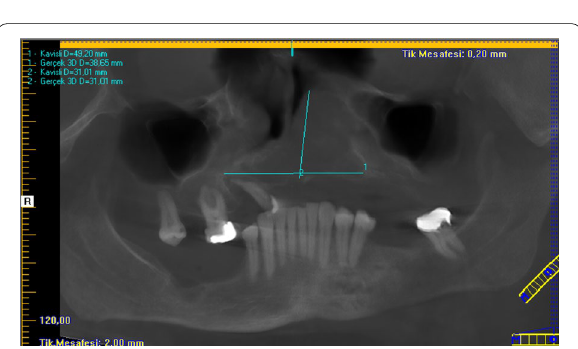
Fig. 3 Lesion size from panoramic